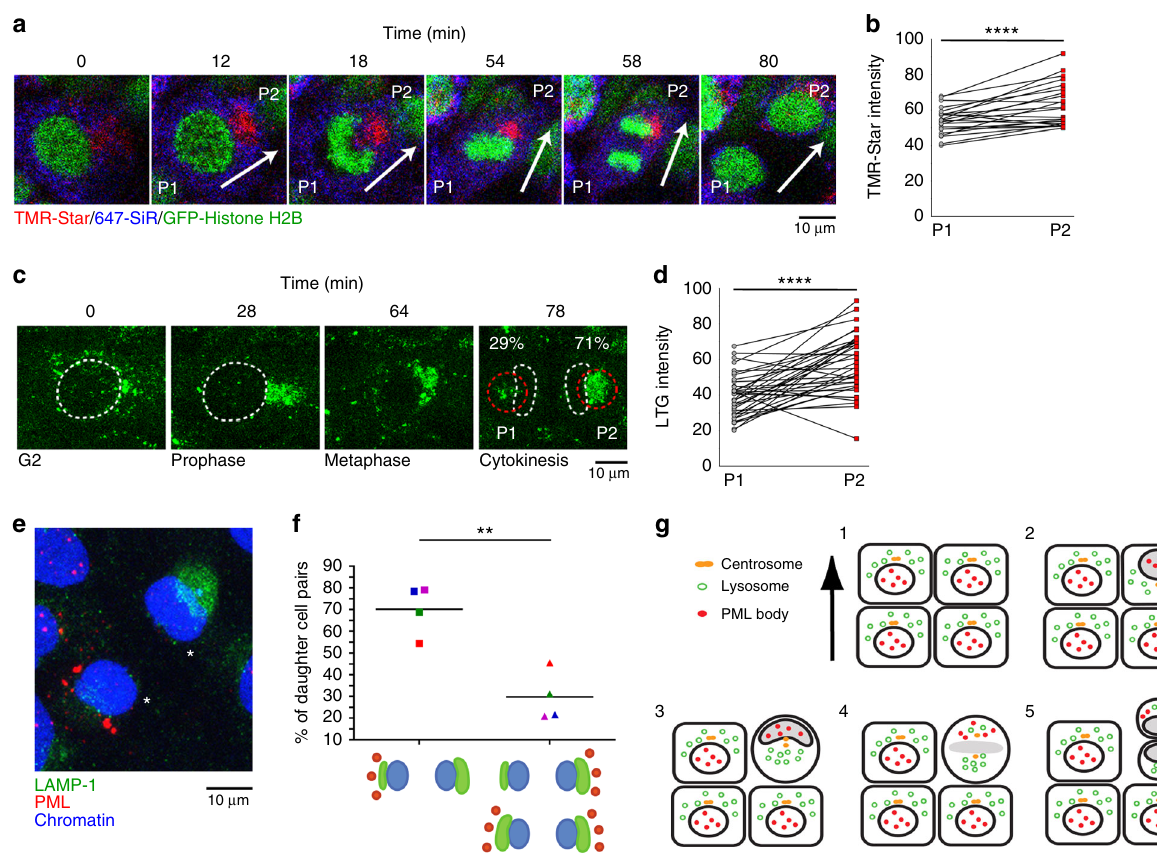
Fig. 6 Asymmetric inheritance of lysosomes. a Time-lapse images of a HaCaT cell expressing Snap-tagged OMP25 and GFP-Histone H2B (green). Quiescent cells were subjected to 647-SiR (blue) and TMR-Star (red) labeling 5 h prior to and 25 h after serum stimulation, respectively. Images are extracted from Supplementary Movie 17. b Quanti fi cation of TMR-Star intensity in newly divided P1 and P2 daughter cells. Paired Wilcoxon's rank-sum test gives a **** p value of 8.8 × 10 − 5 , with mean estimates of 53.92 (95% CI 49.68 – 58.15) and 62.77 (95% CI 58.53 – 67.00) for P1 and P2, respectively ( n = 23). c , d Serum-stimulated HaCaT keratinocytes were treated with LTG immediately prior to imaging starting 25 h post serum stimulation. c Time-lapse images of LTG distribution during cell division. White lines indicate nuclear boundaries. Red circles indicate quanti fi ed regions. Images are extracted from Supplementary Movie 18. d Quanti fi cation of LTG intensity in newly divided P1 and P2 daughter cells. Paired Wilcoxon's rank-sum test gives a **** p value of 1.8 × 10 − 6 , with mean estimates of 39.52 (95% CI 34.75 – 44.30) and 57.43 (95% CI 52.65 – 62.21) for P1 and P2, respectively ( n = 37). e Distribution of LAMP-1 and PML in dividing HaCaT cells after starvation and serum stimulation for 30 h. White asterisks indicate newly divided daughter cell pair. LAMP-1 (green), PML (red), and DAPI (blue) is shown. f Quanti fi cation of relative LAMP-1 and PML body distribution in newly divided daughter cell pairs. A cell division was scored as asymmetric if one of the daughter cells contained the highest LAMP-1 intensity, while the other contained the majority of CyPNs. The scatter plot shows four experiments (each experiment is color-coded). Black lines indicate mean values; ** p = 0.0026. g Illustration showing how the polarized cell division is aligned with cell migration, leading to segregation of PML bodies and lysosomes to the front and rear daughter cell, respectively. Black arrow indicates the direction of